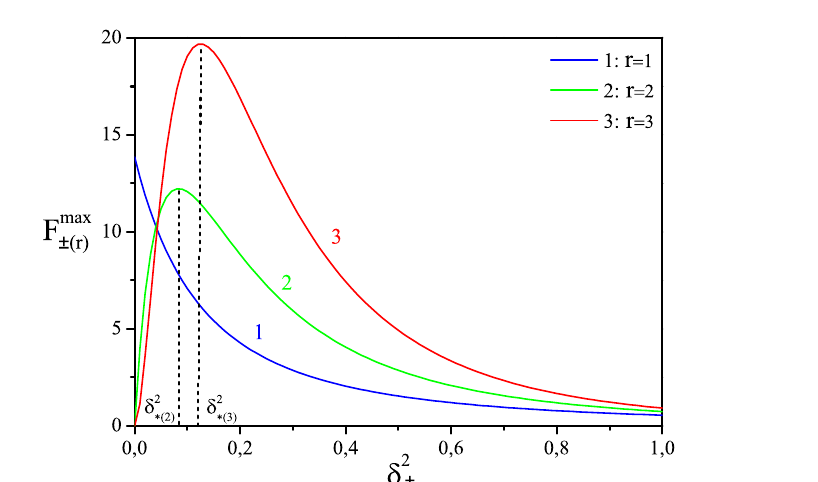
(57) on the parameters δ 2 ± for the first three resonances ± ( r )